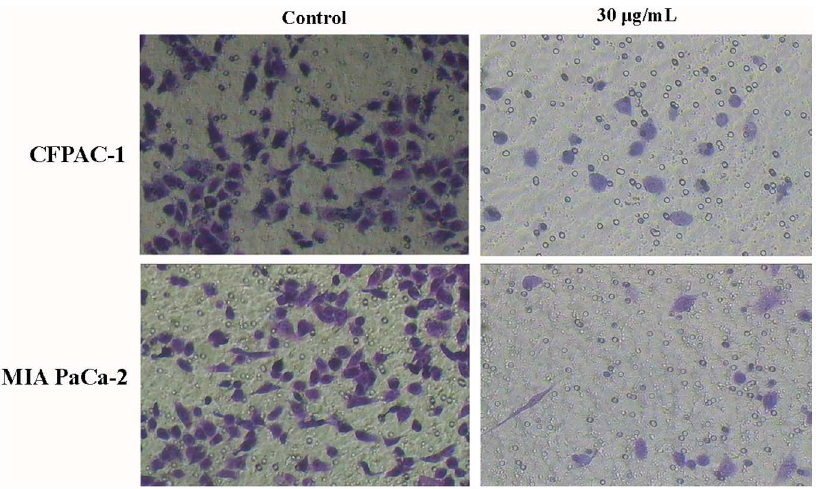
Figure 7. Spiclomazine inhibited cell invasion detected by transwell assay. Cells adhering to the bottom surface of the membrane were stained with 1% crystal violet and then observed under microscopy in three random fields in each well.